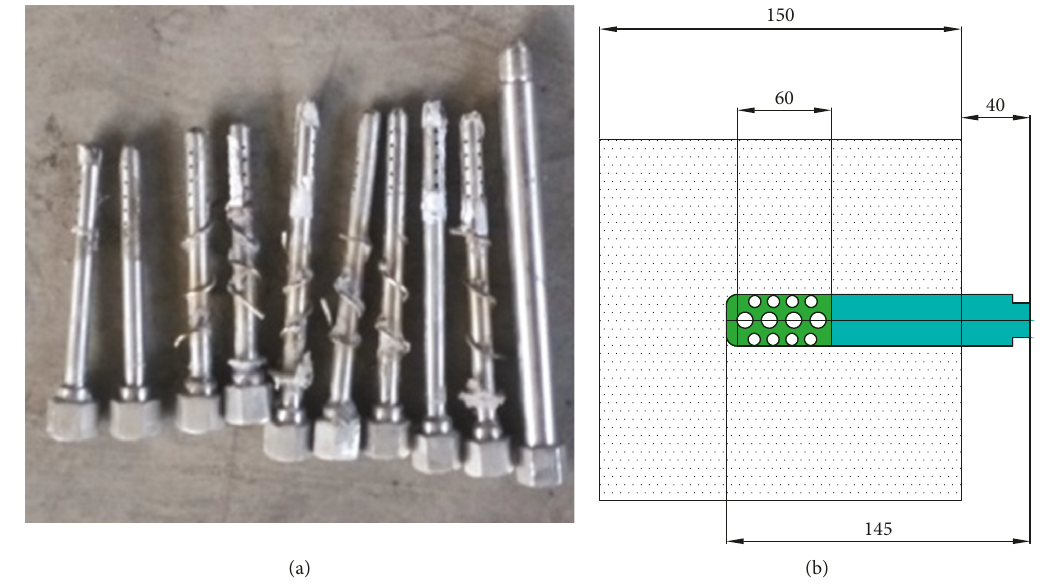
Figure 3: (a) Release tube. (b) Dimensional drawing of release tube. Table 2: The experimental technical parameters every time. No. High-pressure vessel, V (L)